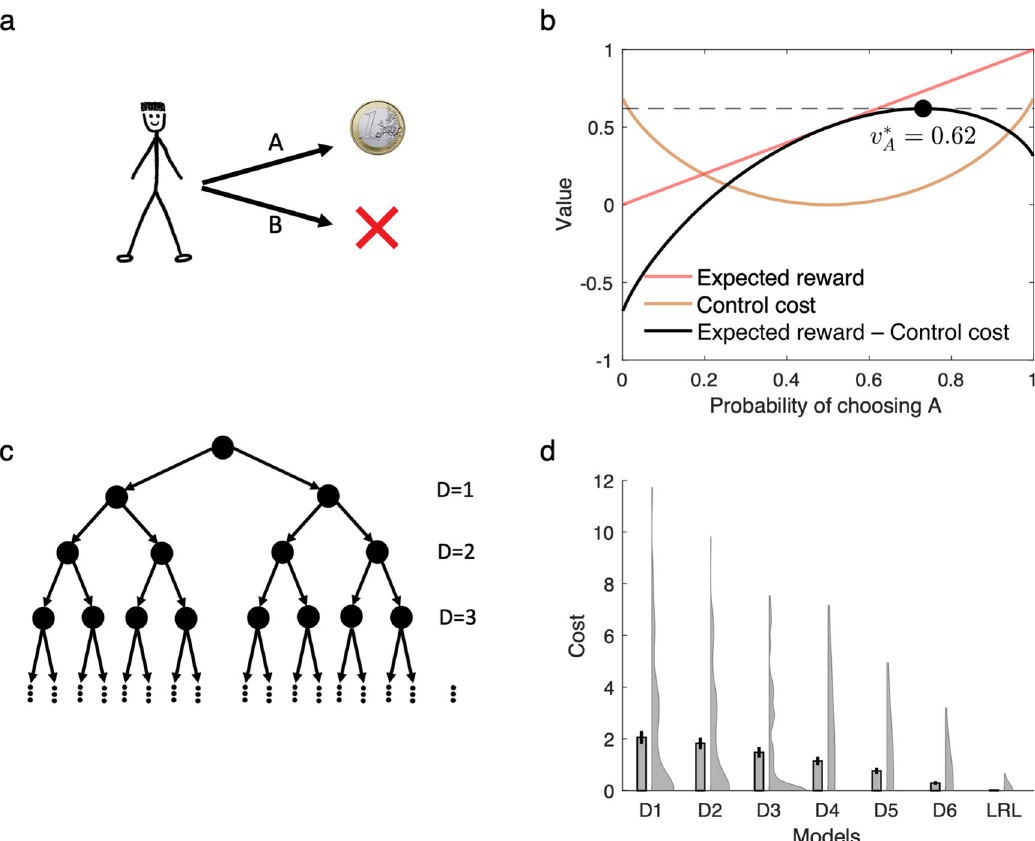
Fig. 1 The linear RL model. a , b The model optimizes the decision policy by considering the reward and the control cost, which is de fi ned as the KL divergence between the decision policy and a default policy. Assuming an unbiased (uniform) distribution as the default policy, the optimal decision policy balances the expected reward with the control cost. Although the expected reward is maximum when probability of choosing A is close to 1 (and therefore probability of choosing B is about zero), this decision policy has maximum control cost due to its substantial deviation from the default policy. The optimal value instead maximized expected reward minus the control cost, which here occurs when probability of choosing A is 0.73. c , d The model accurately approximates optimal choice. We compared its performance on a seven-level decision tree task (with random one-step costs at each state) to six pruned model-based RL algorithms, which evaluate the task to a certain depth (D = 1,..,6; D7 is optimal; D1 is equivalent to the successor representation for the random walk policy) and use average values at the leaves. Linear RL (LRL) achieved near-optimal average costs ( y -axis is additional cost relative to the optimum). Local costs of all states were randomly chosen in the range of 0 – 10, and simulations were repeated 100 times. Mean, standard error of the mean, and distribution of data across 100 simulations are plotted. Source data are provided as a Source Data fi